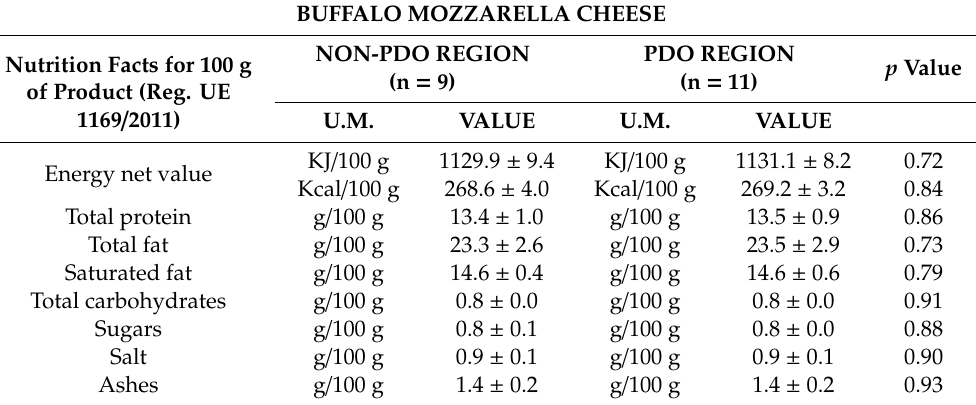
Table 2. Average mozzarella cheese composition of samples from different farms located in protected designation of origin (PDO) and non-PDO regions in Italy. Data are expressed as means ± ES.